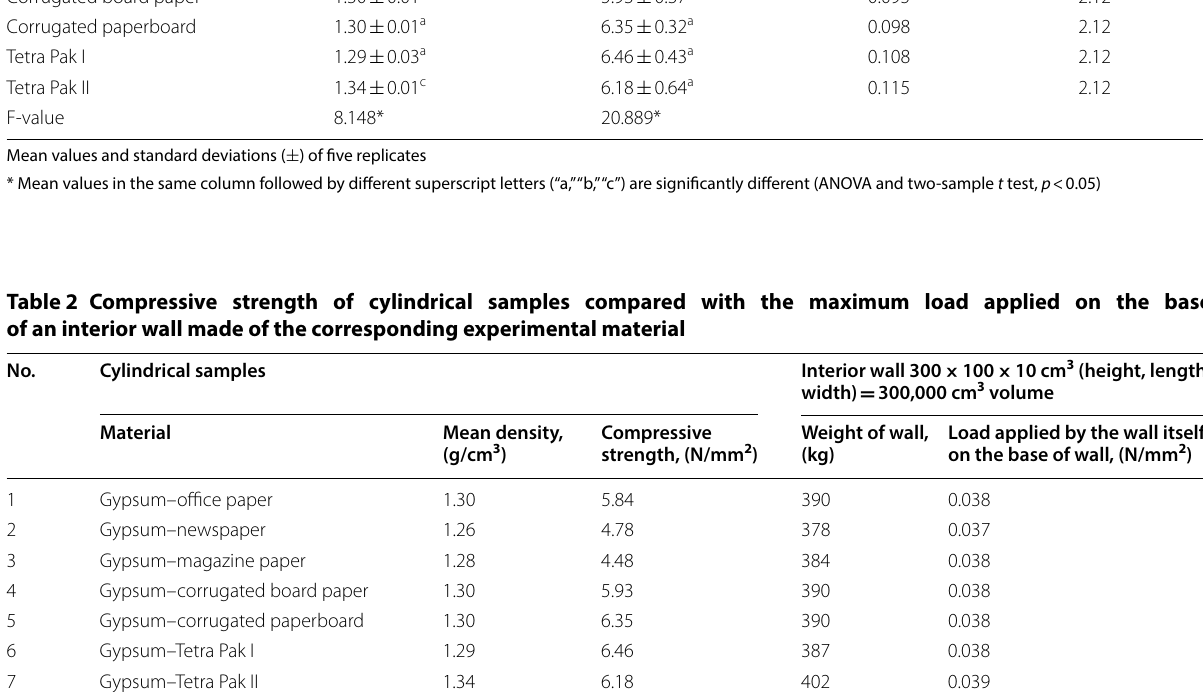
Table 1 Density, compressive strength, bulk density and gypsum/water ratio of different “gypsum–paper” cylindrical samples